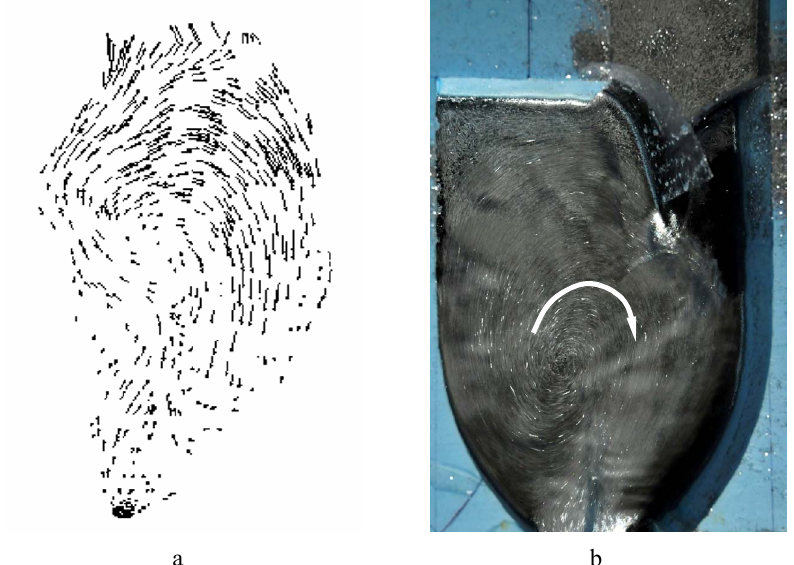
Figure 5: (a) Flow patterns in the left ventricle based on MRI scans (34) . (b) Visualisation of flow structures in the model of the left